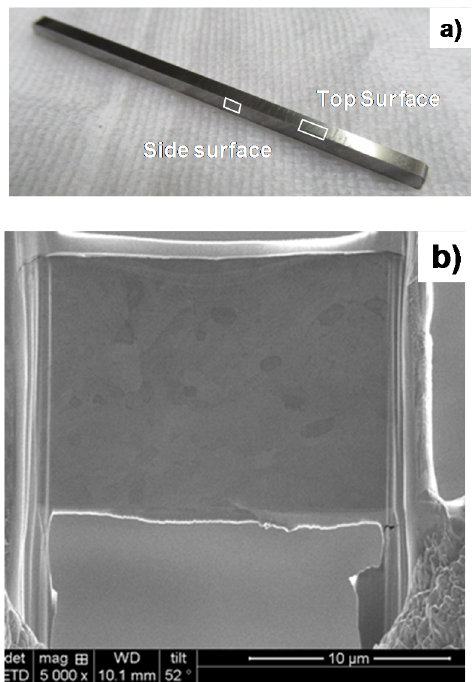
Figure 2. Preparation of specimen from the nitrided AISI420 substrate. ( a ) Ground and polished specimen for SEM-EDX (electron dispersive X-ray diffraction); ( b ) sliced specimen by FIB processing for TEM